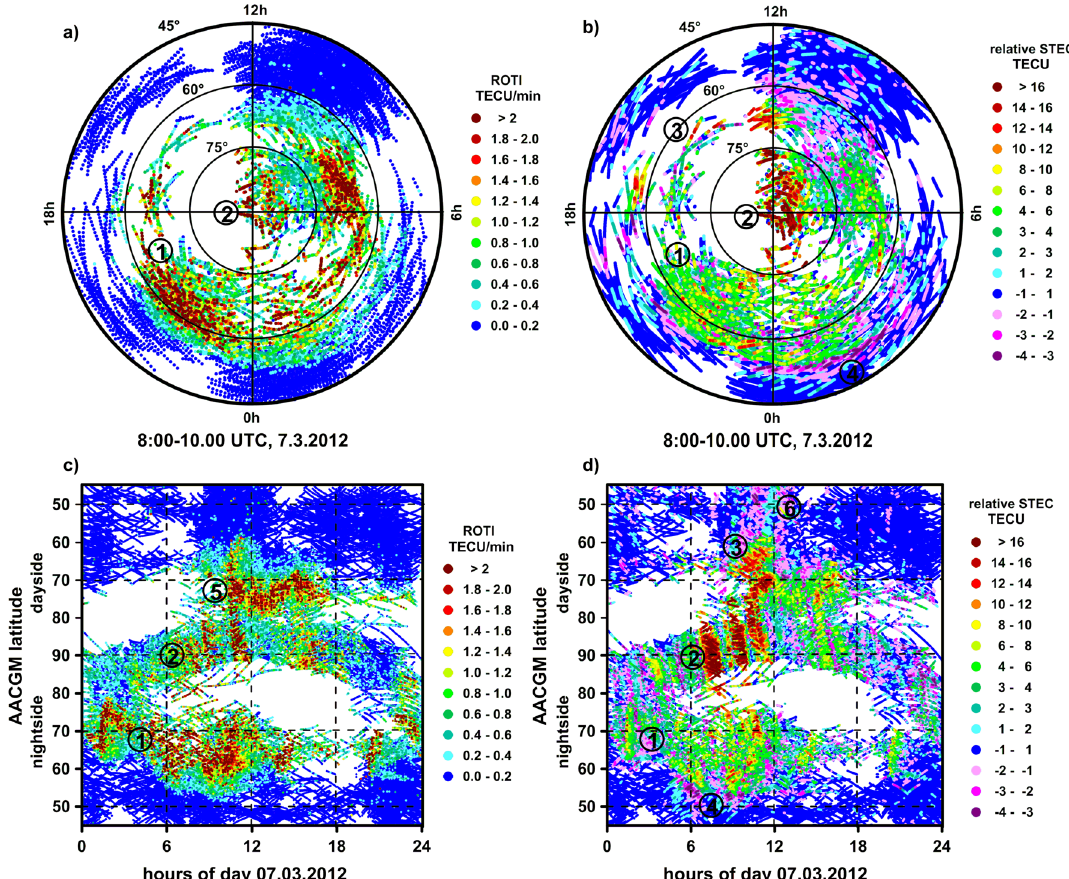
Fig. 6. The comparison of ROTI (left panel) and relative STEC (right panel) values. Top panel: 2-hour point maps (8:00 – 10:00 UT, 7 March 2012) of ionosphere presented as a function of AACGM and MLT. Bottom panel: temporal changes of both parameters observed on day- and night-side ionosphere on 7 March 2012. 1 – auroral oval, 2 – TOI/polar patch, 3 – SED, 4 – ionospheric through, 5 – cusp, 6 –